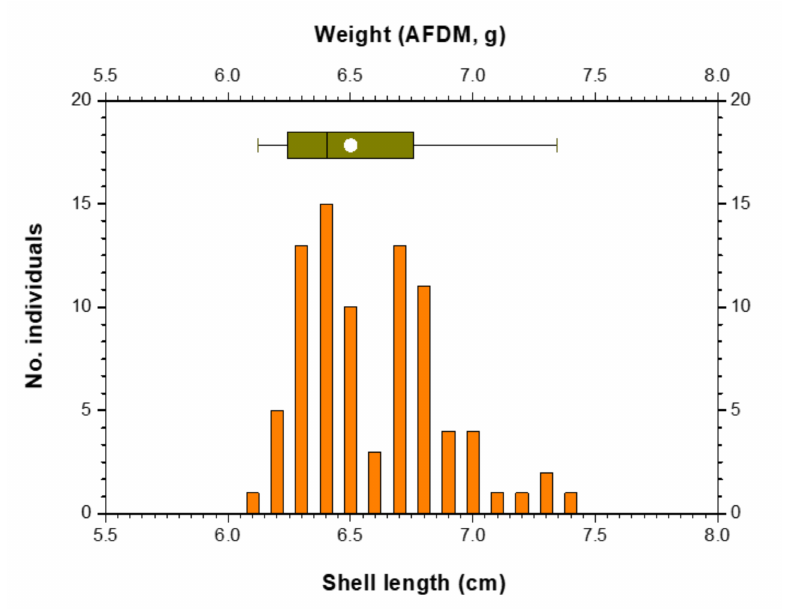
Figure 2. Distribution of shell length and weight (ash-free dry-matter: AFDM) of freshwater bivalve Unio douglasiae Griffith et Pidgeon used in this study ( n =